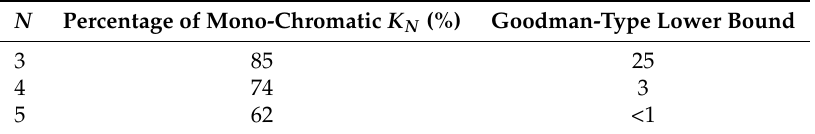
Table 9. Data for the country graph in Section 4.3.